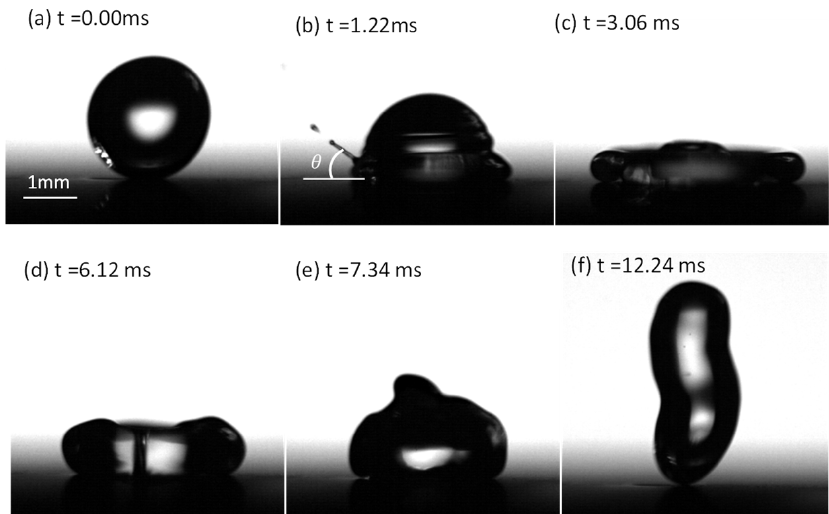
Figure 2. Snapshots showing a drop impacting the dimpled surface at We = 23.41. ( a ) Start of droplet impact at t = 0.00 ms. ( b ) Satellite droplets issued at the end of the Jetting. ( c ) Droplet spreading to its maximum diameter. ( d , e ) Asymmetric morphology of the droplet during retraction. ( f ) The rebound of the droplet from the surface.